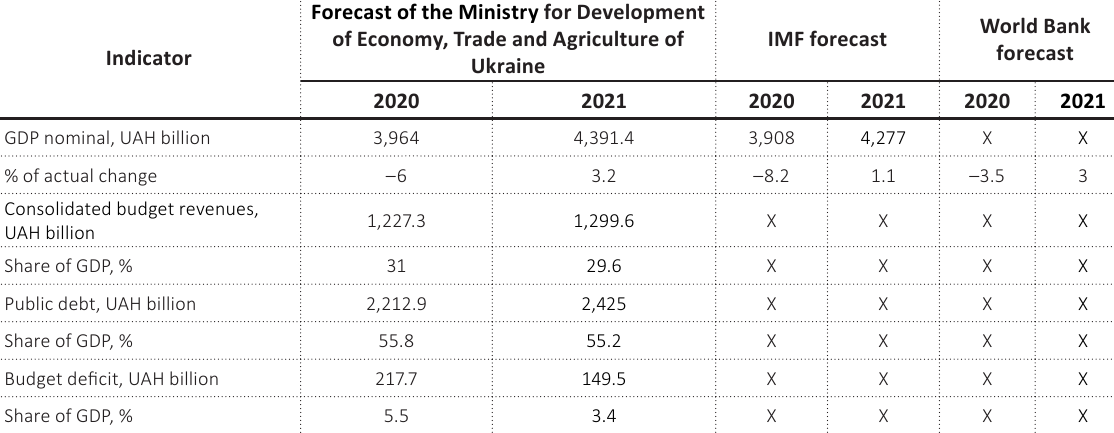
Table 3. Changes in the main predictors of Ukraine’s budget security according to state and